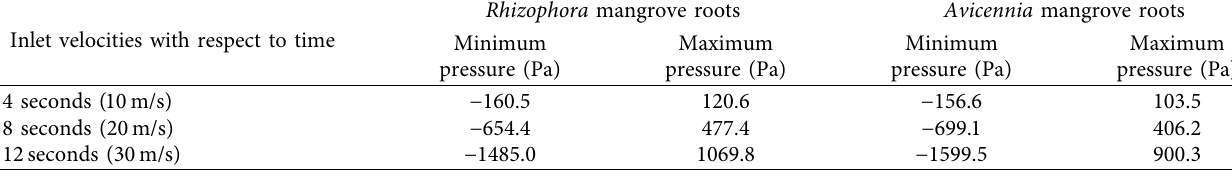
Table 5: The minimum and maximum pressure of flow around Rhizophora and Avicennia mangrove roots at time intervals of 4 seconds, 8 seconds, and 12 seconds.